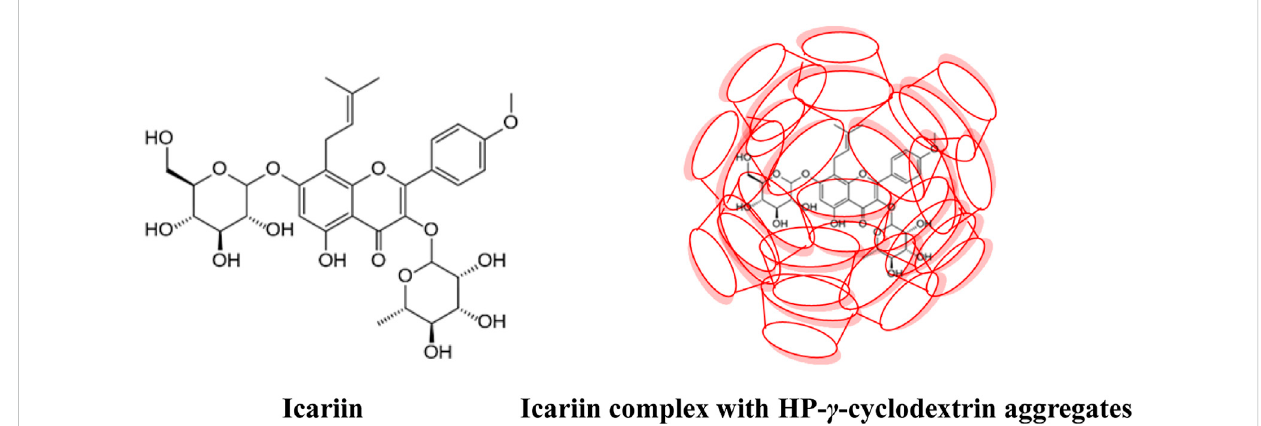
Structures of icariin and its complex with HP- γ -cyclodextrin